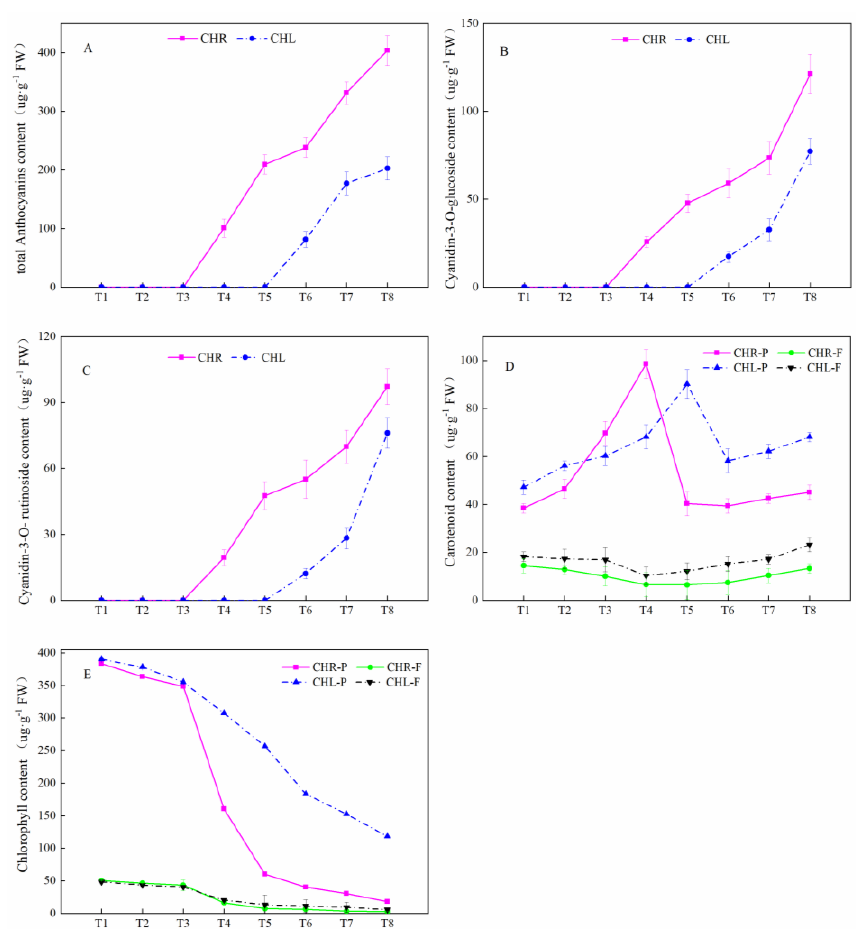
Figure 4. Total anthocyanins content (TMAC), cyanidin − 3 − O − glucoside (C3G) contents, cyanidin − 3 − O − rutinoside (C3R) contents, total carotenoid contents, and total chlorophyll content in CHL and CHR during development. ( A ) TMAC; ( B ) C3G; ( C ) C3R; ( D ) Total carotenoid contents and ( E ) Total chlorophyll content. Each value is the mean for three replicates. The vertical bar indi- cates the standard error.